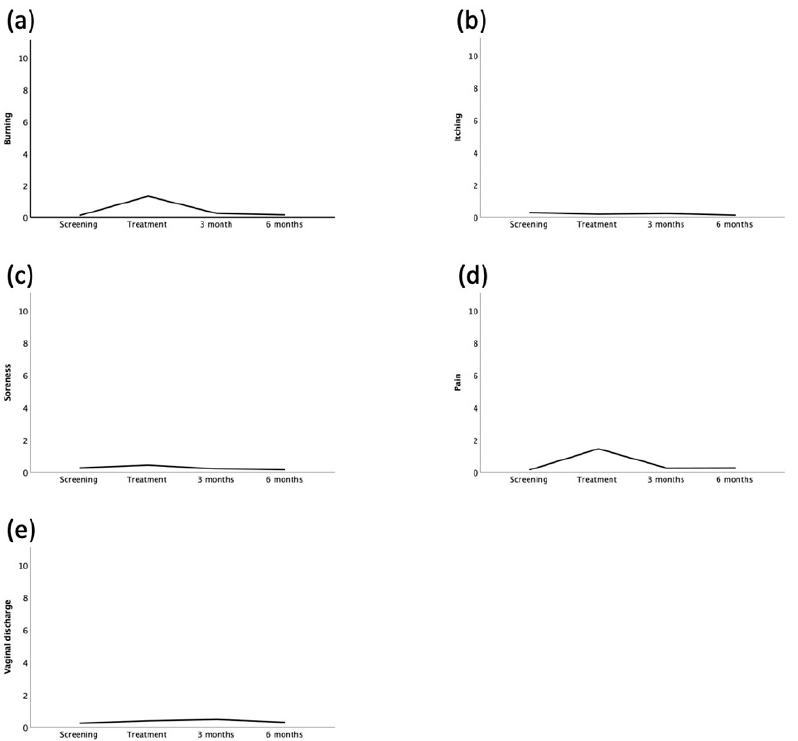
Figure 3. Patient-reported outcomes regarding treatment-associated symptoms before, during, 3 and 6 months after a single treatment with 85% trichloroacetic acid. ( a ) Burning, ( b ) itching, ( c ) soreness, ( d ) pain, and ( e ) vaginal discharge.